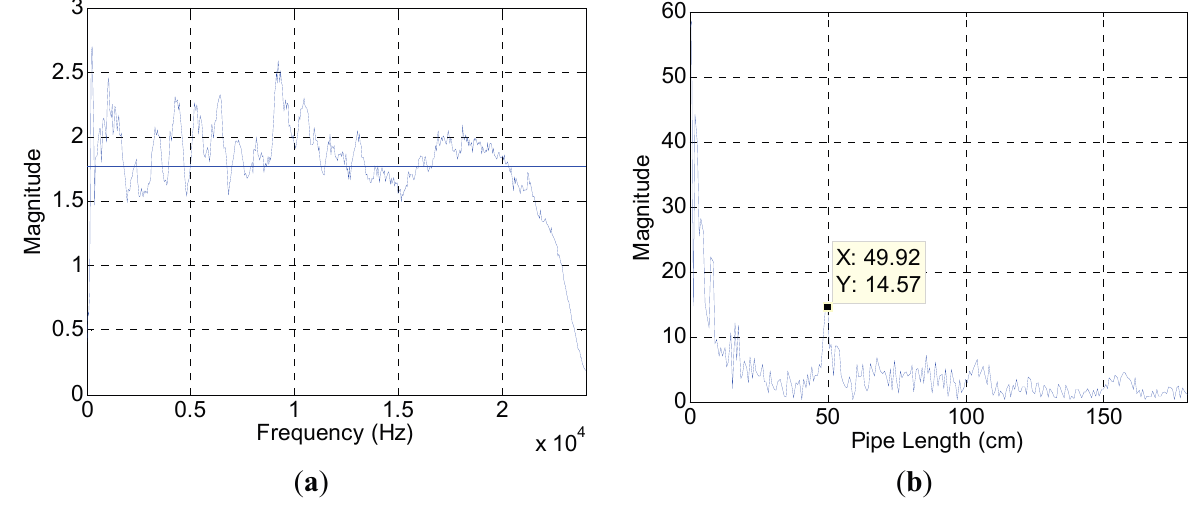
Figure 3. ( a ) Spectrum plot without a pipe based on the white noise; ( b ) Length estimation plot with a 50 cm pipe.